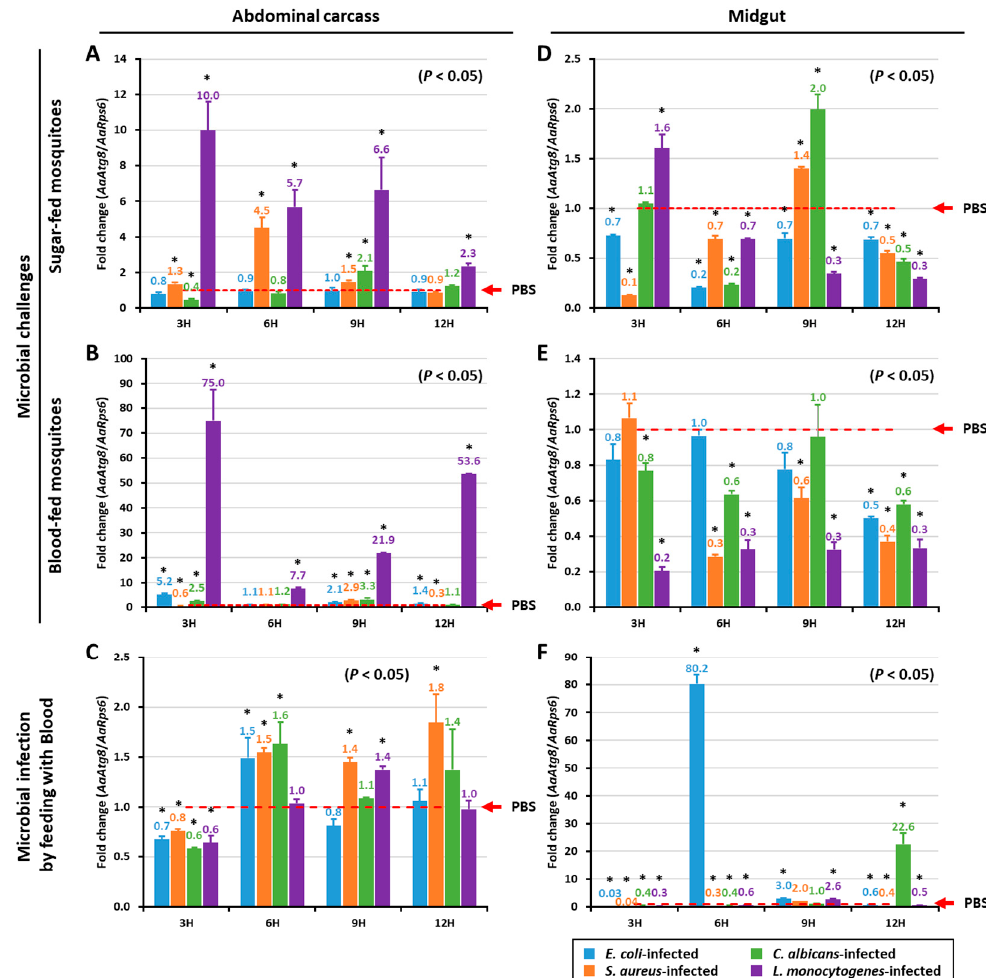
Figure 4. Temporal expression of AaAtg8 mRNA in response to microorganism challenge by injection and feeding. AaAtg8 mRNA levels are expressed as fold changes and were measured in the abdominal carcass and midgut tissue. While the expression profiles of AaAtg8 mRNA in the abdominal carcass of sugar-fed and blood-fed mosquitoes after the microorganisms challenge are shown in ( A , B ), the expression profiles of AaAtg8 mRNA in the midgut tissue of sugar-fed and blood-fed mosquitoes after microorganisms challenge are shown in ( D , E ). The expression profiles of AaAtg8 mRNA after microbial infection by feeding with blood in the abdominal carcass and midgut are shown in ( C , F ), respectively. The fold change in expression levels in groups infected with microorganisms was compared with the phosphate-bu ff ered saline solution (PBS)-injected (control) group. The Ae. albopictus ribosomal protein S6 ( AaRps6 ) mRNA expression was used as an endogenous control. Results of the triplicate experiments are shown with standard errors. An asterisk indicates significance at a 95% confidence level (Statistical Analysis Software, ANOVA).